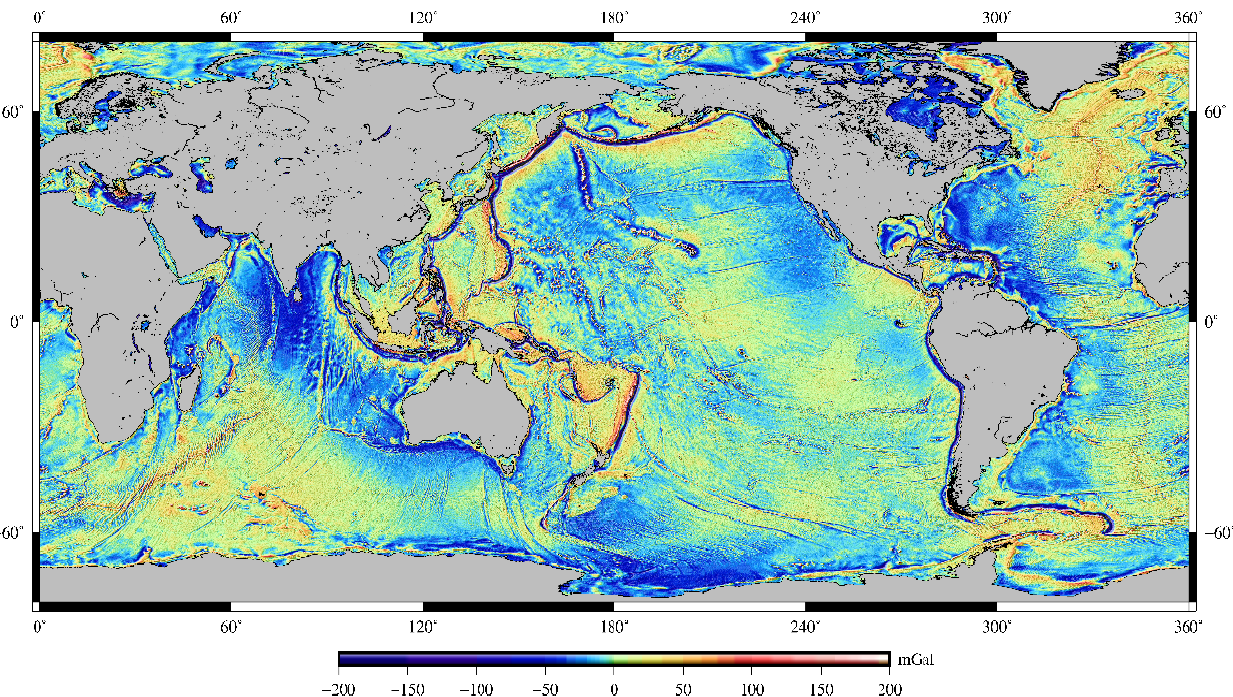
Figure 1. Global marine gravity anomaly (free air) model SDUST2021GRA.